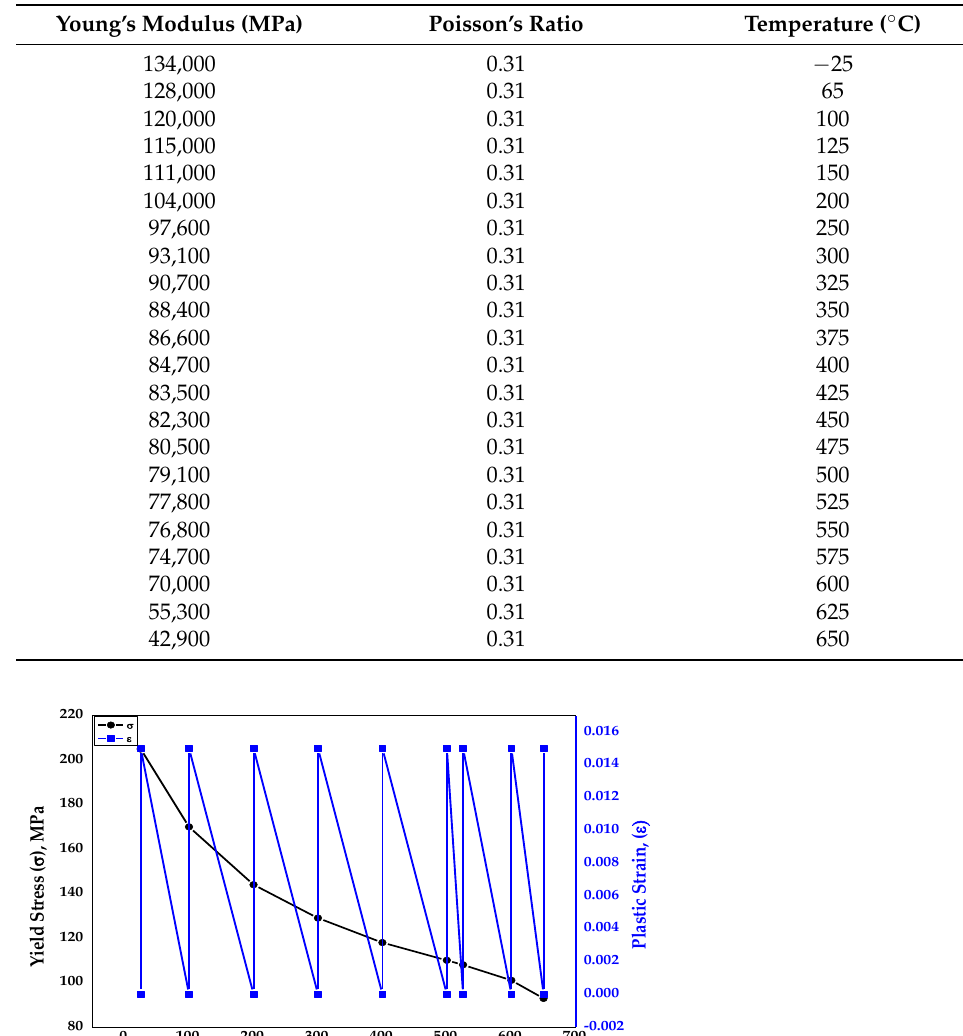
Table 2. Physical properties for SS-316 at selected temperatures [44].